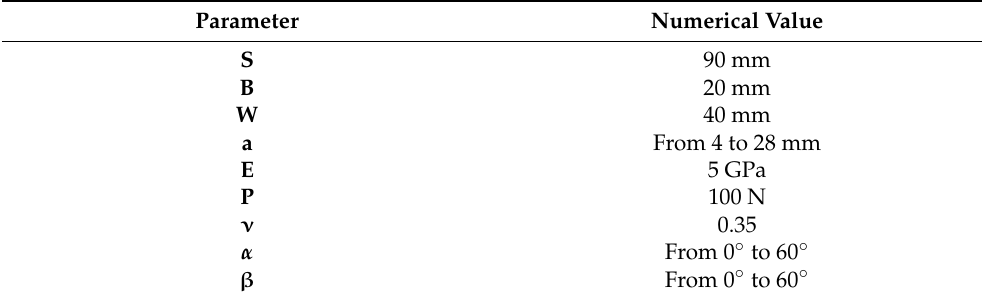
Figure 2. Finite element model and zoomed view of crack tip region for the TPB-IC specimen. Table 2. Material characteristics and geometric dimensions given for the finite element model of the TPB-IC